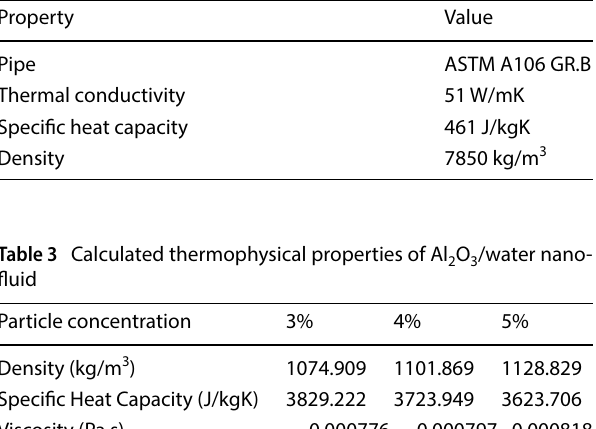
Table 2 Thermophysical properties of WCP pipes